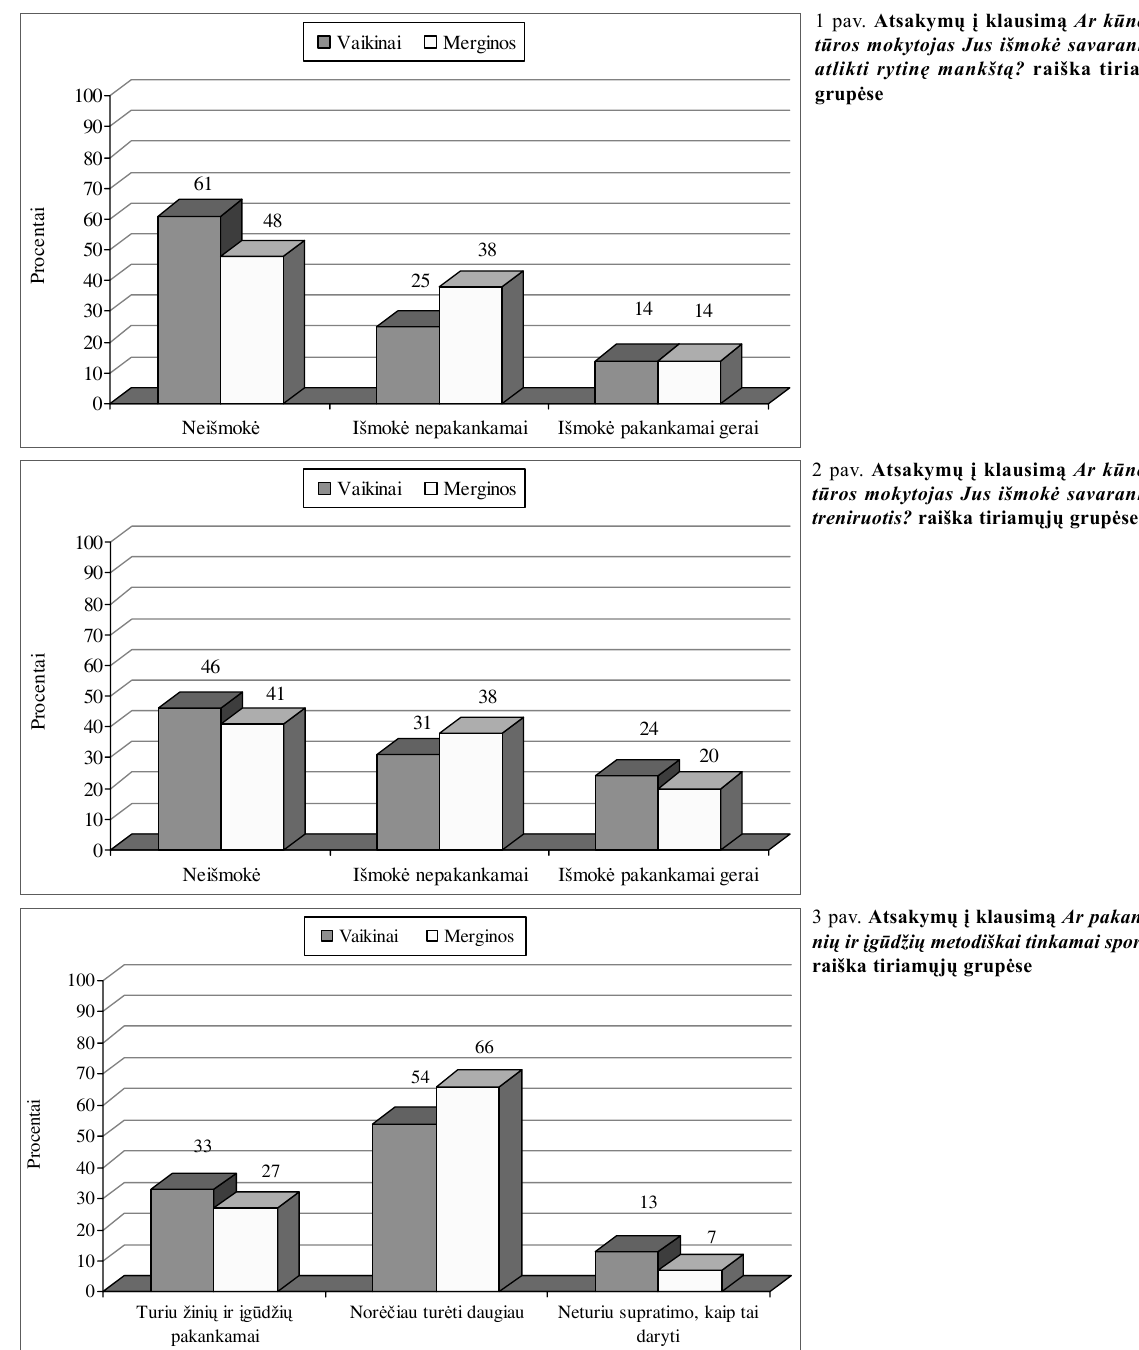
gumui gerinti. Analizuojant priežastis, l ė musias nor ą savaran- kiškai sportuoti arba lankyti organizuotas pratybas, matyti (3 lent.), kad vaikinai pagrindine priežas- timi laiko nor ą b ū ti fi ziškai stipriems — 31%, tuo tarpu ši ą priežast į pamin ė jo tiktai 14% mergin ų . Mergin ų pagrindinis motyvas sportuoti buvo